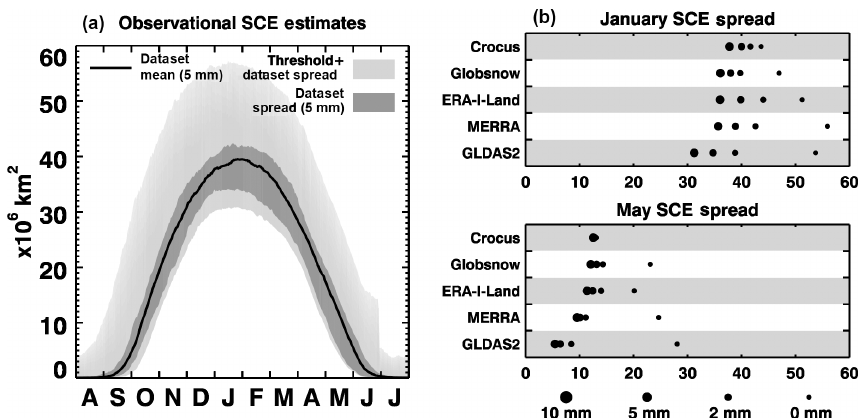
Figure 10. (a) Daily median and spread (5th–95th percentile) among the five snow products for SCE calculated using a 5mm SWE threshold (solid curve and dark shading) and spread calculated using a range of thresholds between 0 and 10mm (light shading). (b) January and May SCE for four choices of